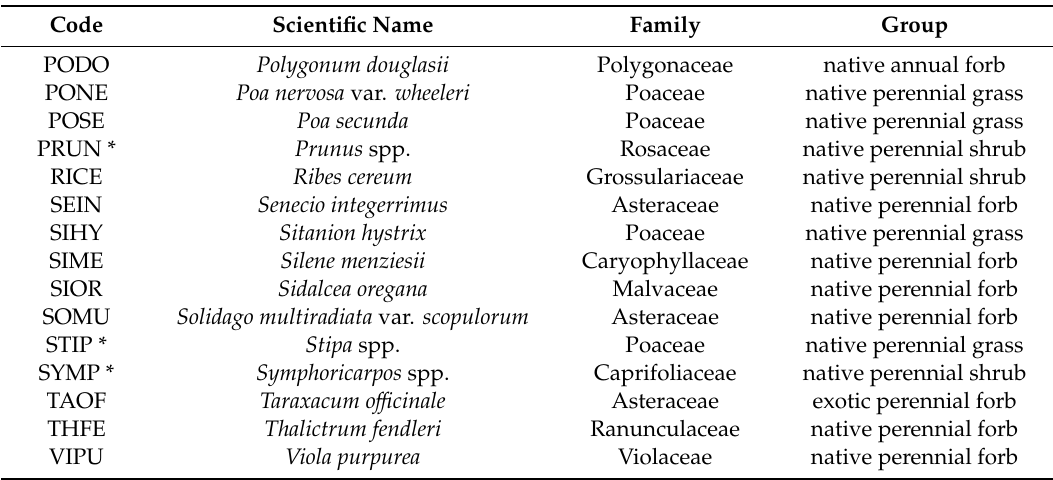
Table A2. Continued: Species codes, scientific names, and general groups for all understory plant species used in